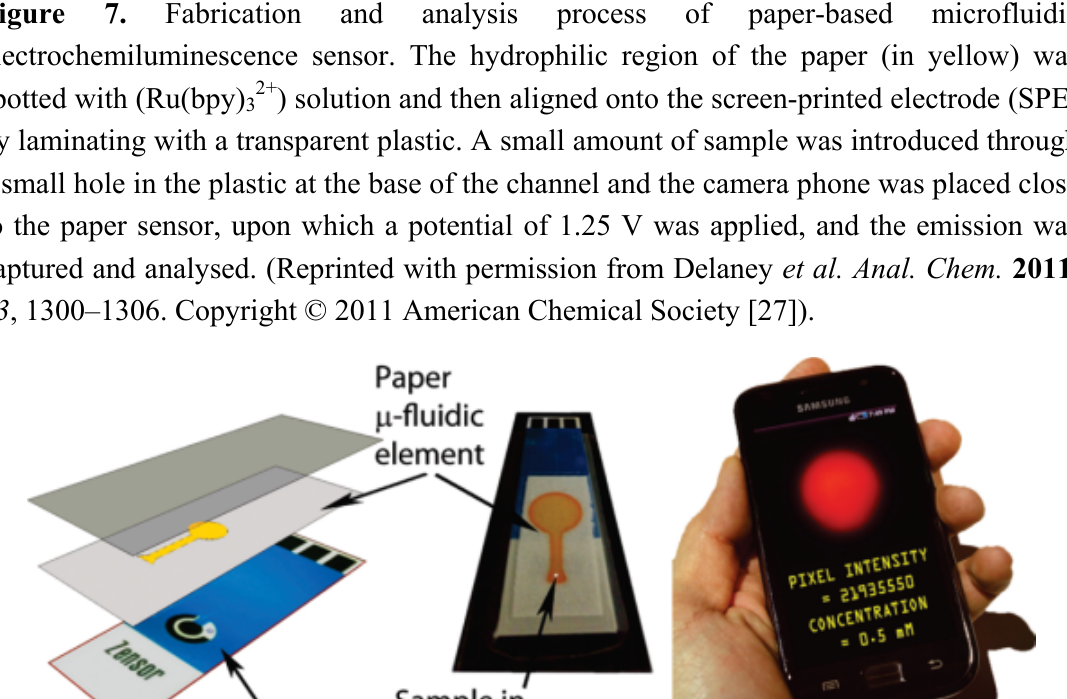
Figure 7. Fabrication and analysis process of paper-based